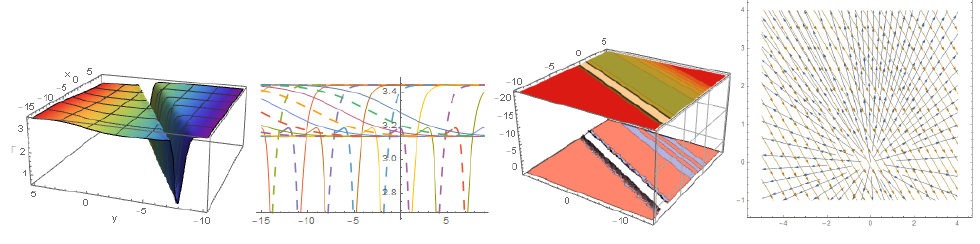
Figure 14. Multi-wave sketches of Γ 6 ( x , ty , t ) in Equation (36) via l 1 = 4, η = 1, c = 1, ρ = 3, l 0 = 2, m 2 = 3, m 6 = 2, λ = 1.2, δ = 2, l 2 = 12, t = 9, and m 4 = 4.5.